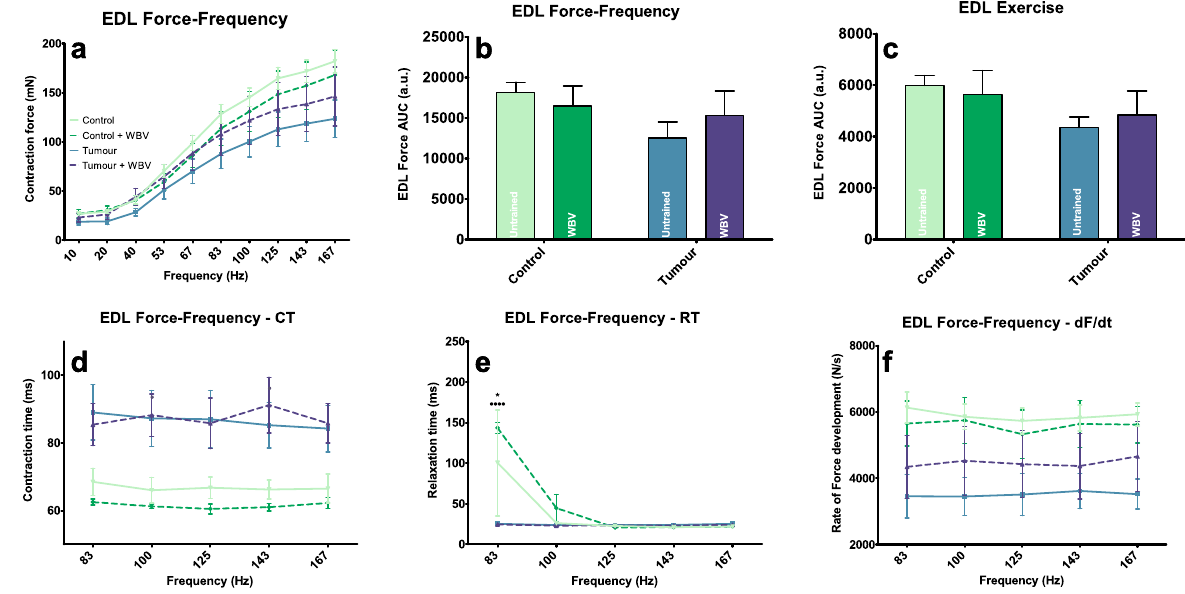
Figure 3. EDL ex-vivo muscle characteristics. Maximal tetanic force, at different stimulation frequencies ( a ) and area under the curve of the force-frequency (FF) relationship ( b ) and the exercise protocol ( c ). Contraction time ( d ), relaxation time ( e ) and rate of force development ( f ). Data represent mean ± SEM. Asterisks indicate significant differences between C and T and dots indicate significant differences between C + WBV and